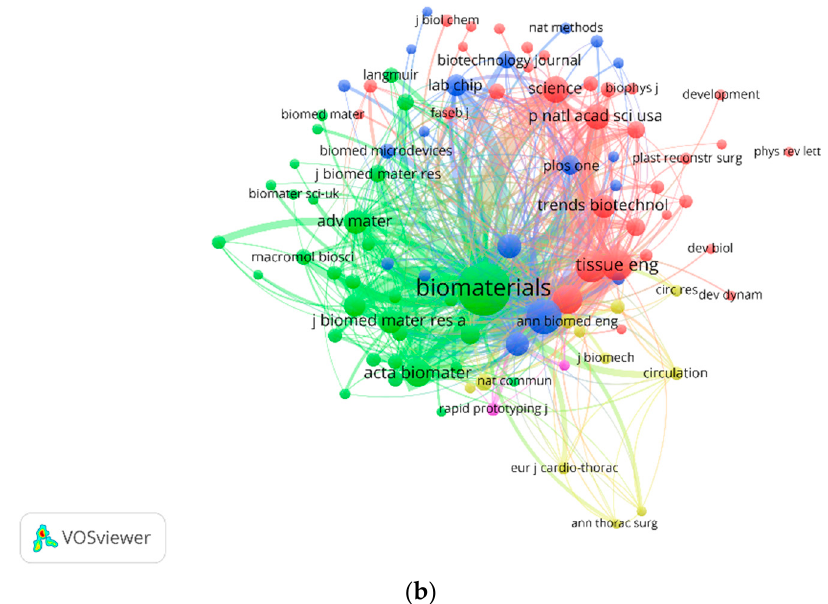
Figure 6. Temporal evolution of the publishing journals. Co-citation analysis of the citations sources between 2006 and 2016 with a time interval of 5 years, ( a ): 2006–2010; ( b ): 2011–2015. The size of each node is proportionate to its degree and the thickness of the links represents the tie strength.